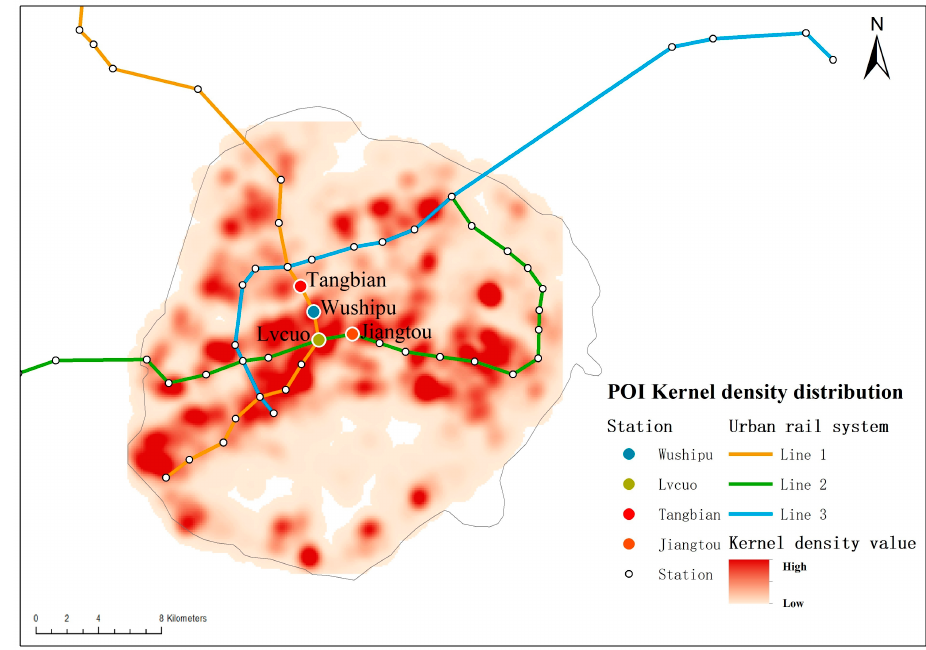
Figure 4. Selected urban rail stations on Xiamen mainland.